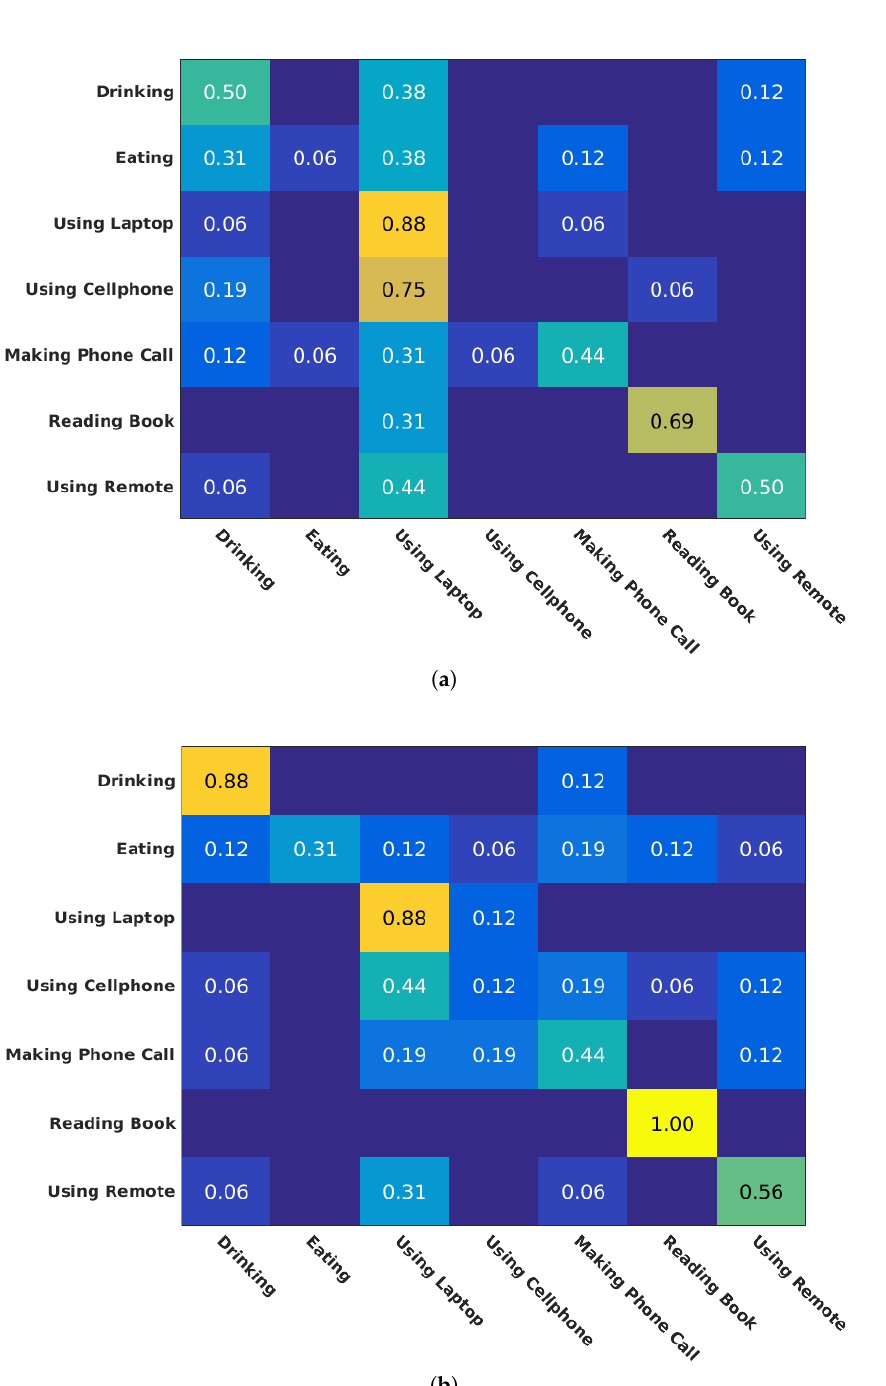
Figure 6. Confusion matrices obtained for Dense Trajectories ( a ) and 2D Localized Trajectories ( b ) approaches